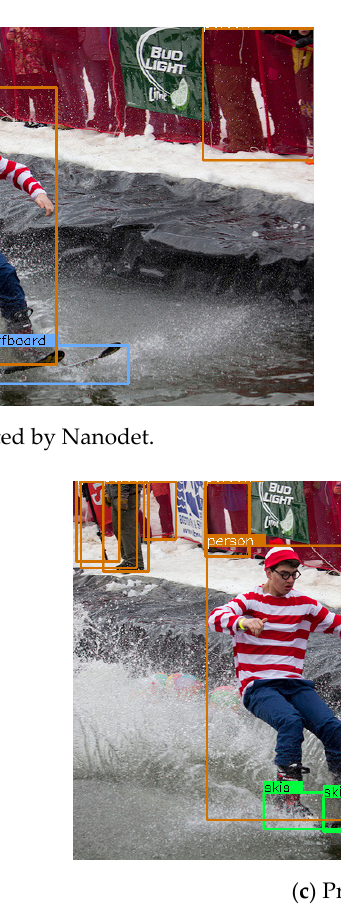
Figure 6. Performance comparison for water-skiing image.